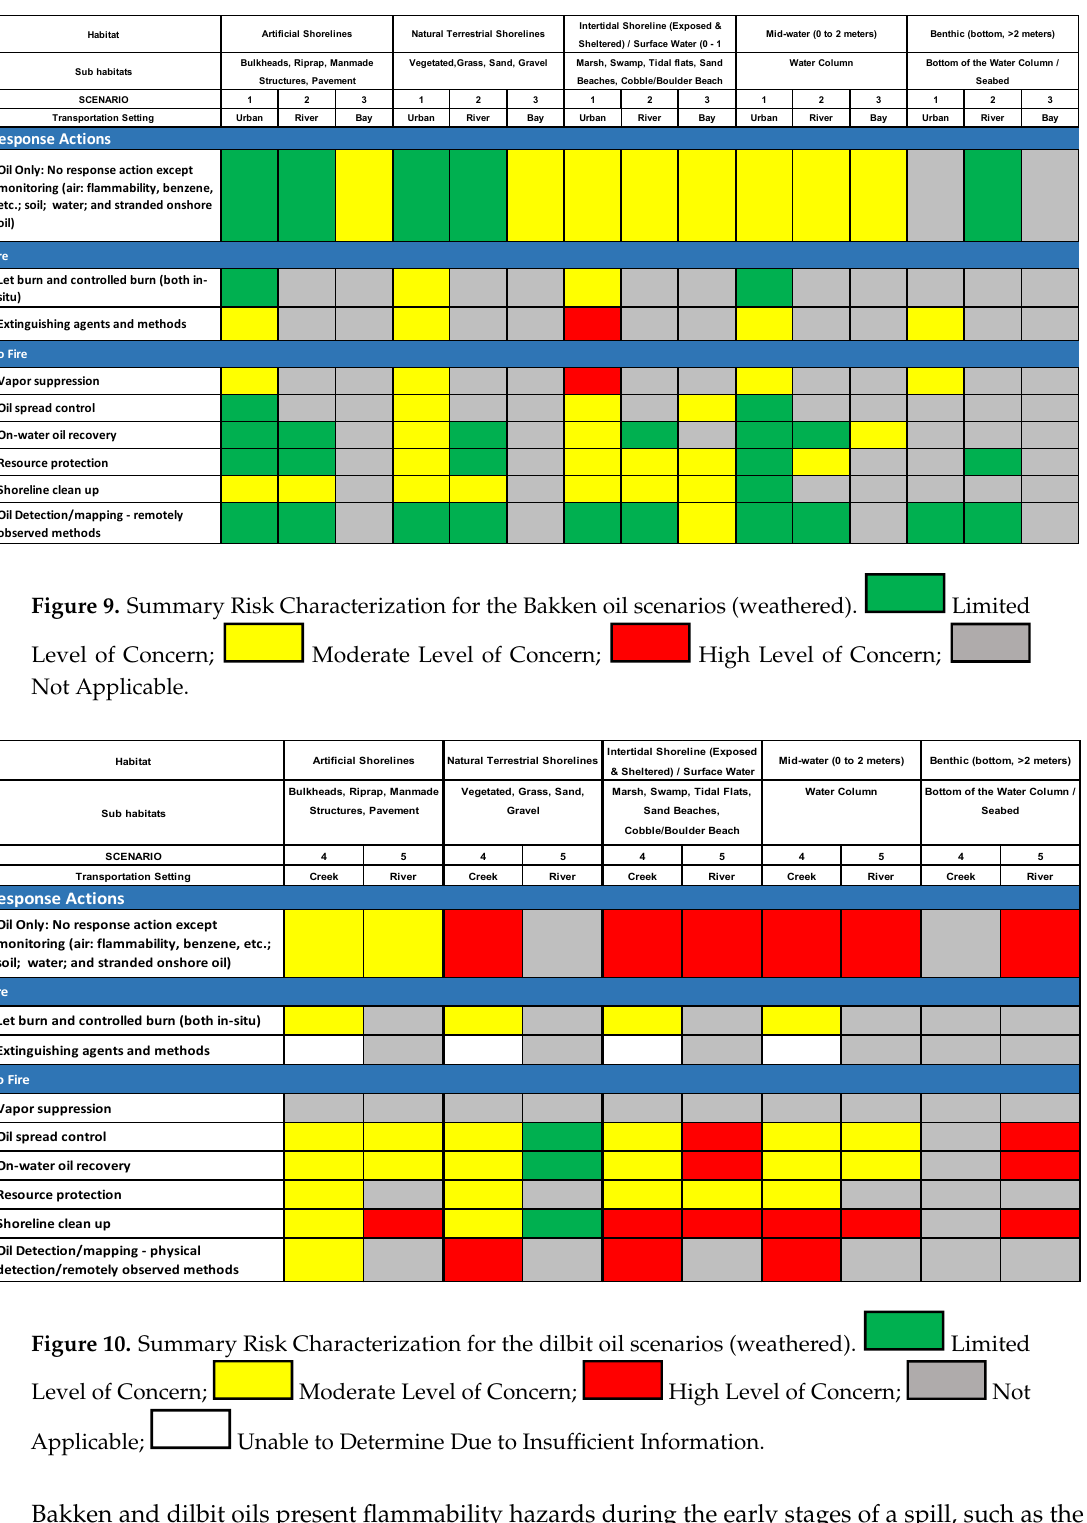
Figure 7. Summary Risk Characterization for the Bakken oil scenarios (initial release). Limited Level of Concern; Moderate Level of Concern; High Level of Concern; High Level of Concern; High Level of Concern; Not Applicable.